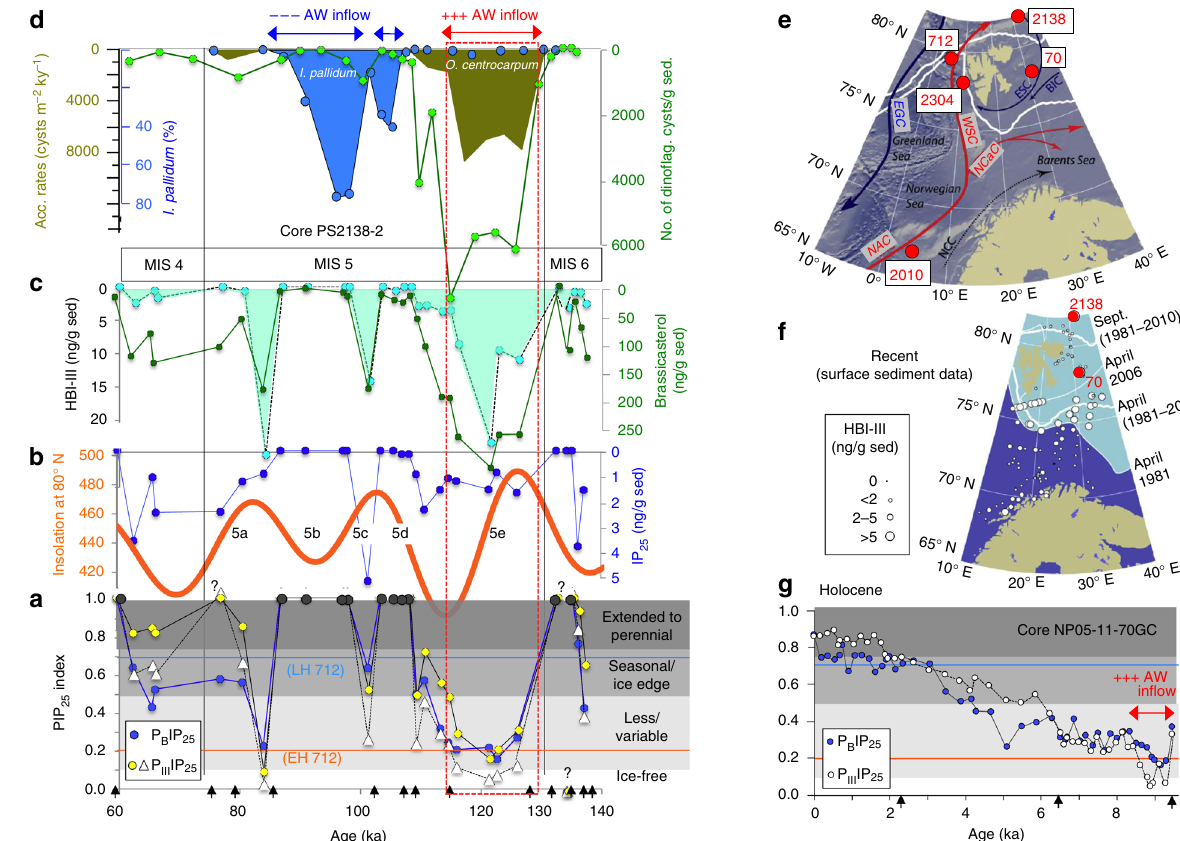
Fig. 7 Sea ice proxy and dino fl agellate cyst records of the time interval 140 – 60 ka at Core PS2138-2. The age model of Core PS2138-2 is based on ref. 67 . a PIP 25 index values representing semi-quantitatve data of sea ice concentrations, based on HBI-III (P III IP 25 ; yellow circles c = 0.32, white triangles c = 1) and brassicasterol (P B IP 25 ; blue circles c = 0.016); for background and calculation of c factors see Methods. For permanent (perennial) sea ice conditions characterized by zero or near-zero concentrations of IP 25 and phytoplankton biomarkers (cf., Figs. 2d and 3b), PIP 25 is indeterminable and set to “ 1 ” ( dark gray circles) . PIP 25 values < 0.1, between 0.1 and 0.5, 0.5 and 0.75, and > 0.75 point to ice-free conditions, a reduced/variable sea ice cover, a seasonal sea ice cover including an ice edge situation, and an extended to perennial sea ice cover, respectively. EH 712 ( orange horizontal line ) and LH 712 ( blue horizontal line ) indicate mean Early Holocene and Latest Holocene values, respectively 32 . Concentrations in ng/g sediment of b IP 25 and c HBI-III and brassicasterol. Summer insolation at 80 °N is shown as an orange curve 78 . d Numbers of total dino fl agellate cysts per gram sediment (green circles), concentration of centrocarpum ( olive-colored graph ) indicative of warm Atlantic Water in fl ow 42 . Blue and red horizontal arrows indicate time intervals with reduced